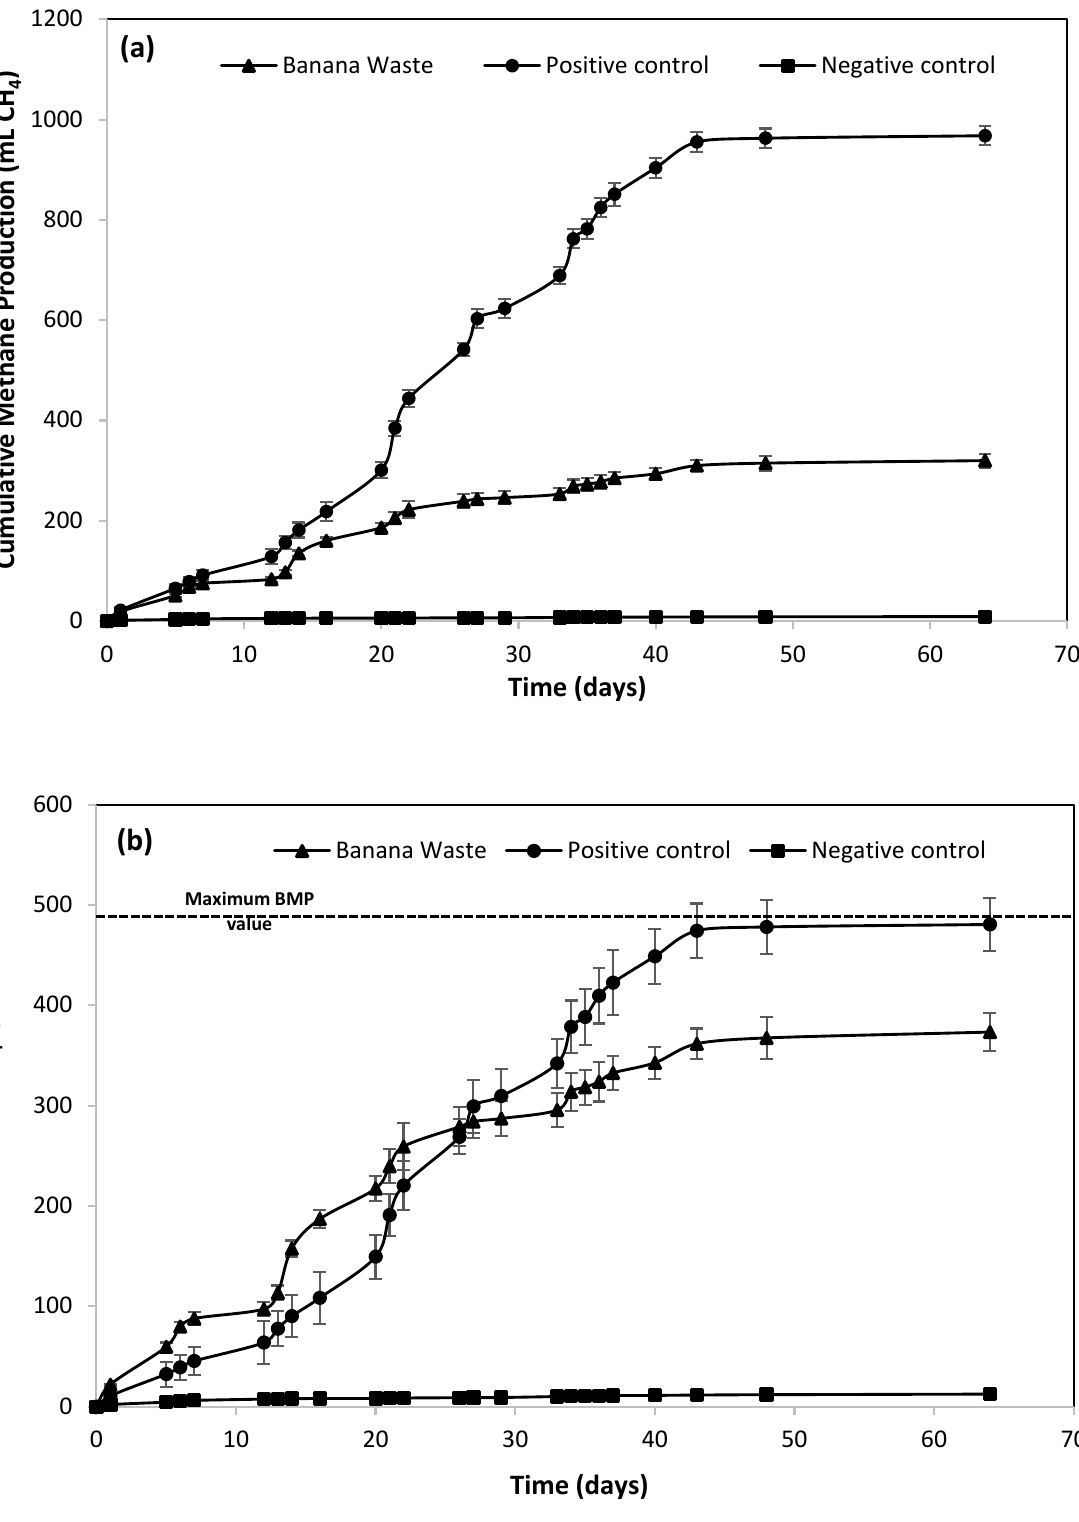
Figure 3. Cumulative methane production ( a ) and biochemical methane potential test ( b ). Each kinetics value represents the mean of three replicates ± SD.